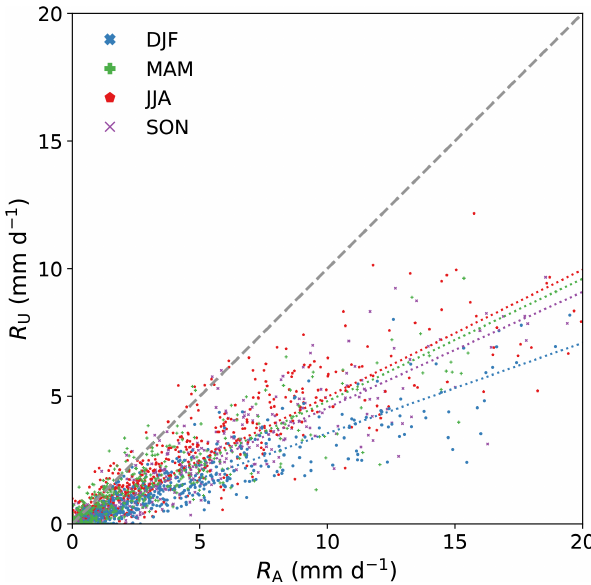
Figure 2. The systematic discrepancy between the reference rain- fall ( R A ) and the unadjusted radar QPE ( R U ). Shown are the daily country-average rainfall sums based on 10 years (2009–2018), clas- sified per season. The slope, Pearson correlation and sample size per season are indicated in Table 1. The dashed colored lines are a linear fit, forced through the origin, per season between R A and R U